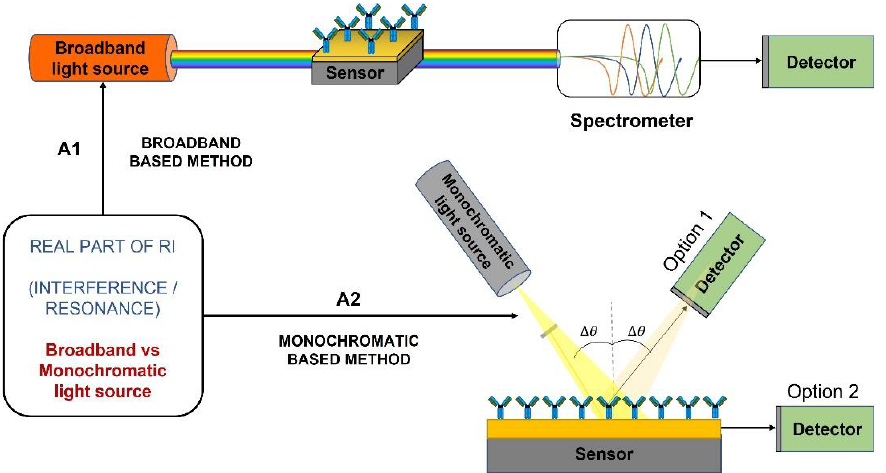
Figure 8. Classification based on the monitored changes in the real part of the refractive index: A1 — Broadband Based/A2 — Monochromatic Based or broadband source plus a monochromator.